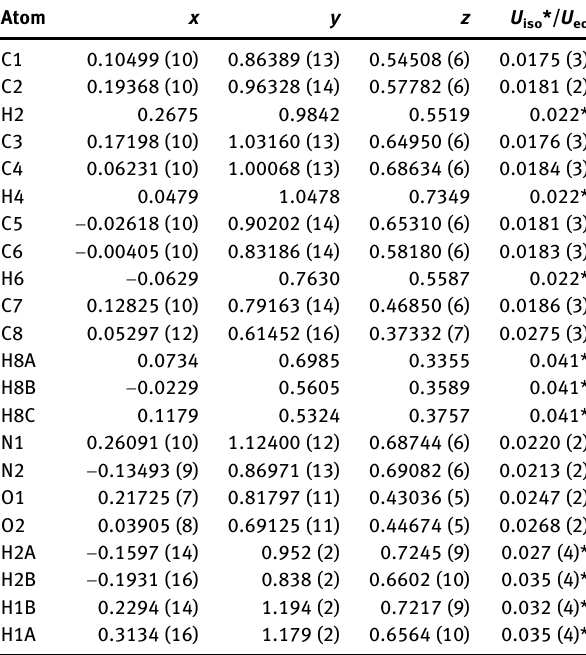
Table  : Fractional atomic coordinates and isotropic or equivalent isotropic displacement parameters (Å 